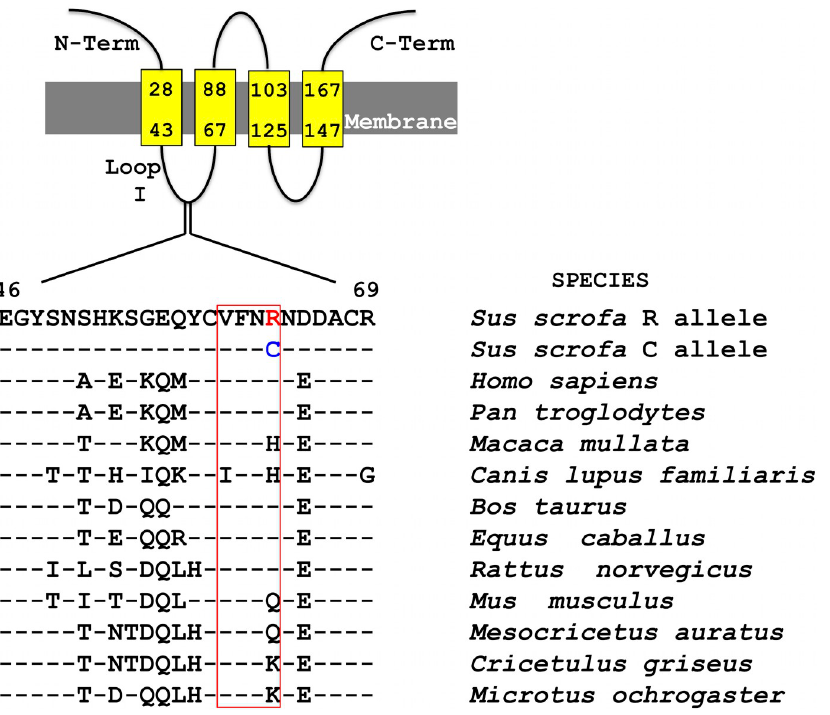
Fig 4. Sequence alignment of the first loop of SYNGR2 across mammalian species. The red block indicates a conserved region demonstrated to be important in successful incorporation of the protein into vesicular membranes and vesicle